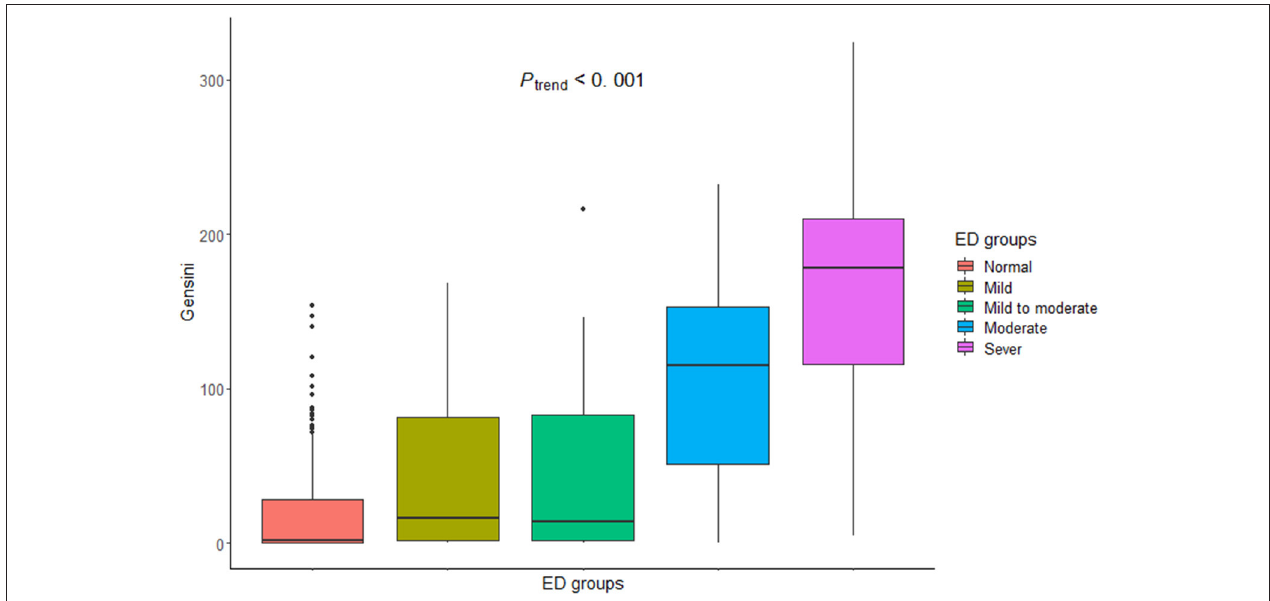
FIGURE 1 | Gensini score among different groups of varying ED